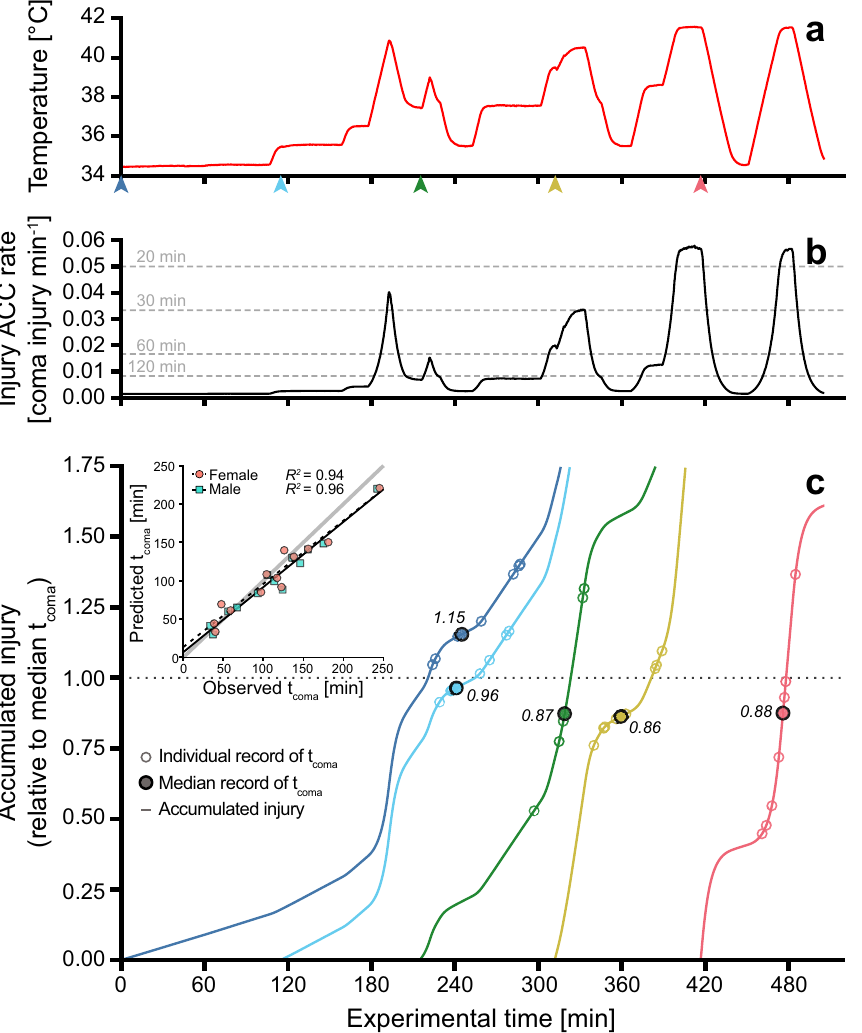
Figure 4. Test of injury additivity during random temperature fluctuations. ( A ) Fluctuating temperature profile from one of the experiments. ( B ) The corresponding temperature specific injury accumulation (ACC) rates for each 10-s interval calculated from the TDT curve (Fig. 3A). Rates are presented as a fraction of coma injury min −1 (i.e. 0.01 corresponds to an injury rate that would cause coma in 100 min), and dashed lines show the injury accumulation rate that, if held constant, would result in coma after 20, 30, 60 and 120 min. ( C ) Groups of flies (n = 8–9) were introduced at different times during the assay (arrowheads in ( A )), and thus each group experienced a unique sequence of fluctuating temperatures. The temperature-specific injury accumulation rates were used to predict the gradual injury accumulation (coloured lines), and accordingly, when each experimental group should have accumulated the critical amount of injury according to the TDT curve (fraction = 1, dotted line). Numbers accompanying median points are the calculated amount of injury accumulated at that specific time for this group. (Inset) Observed vs predicted t coma from all experiments (grey line of